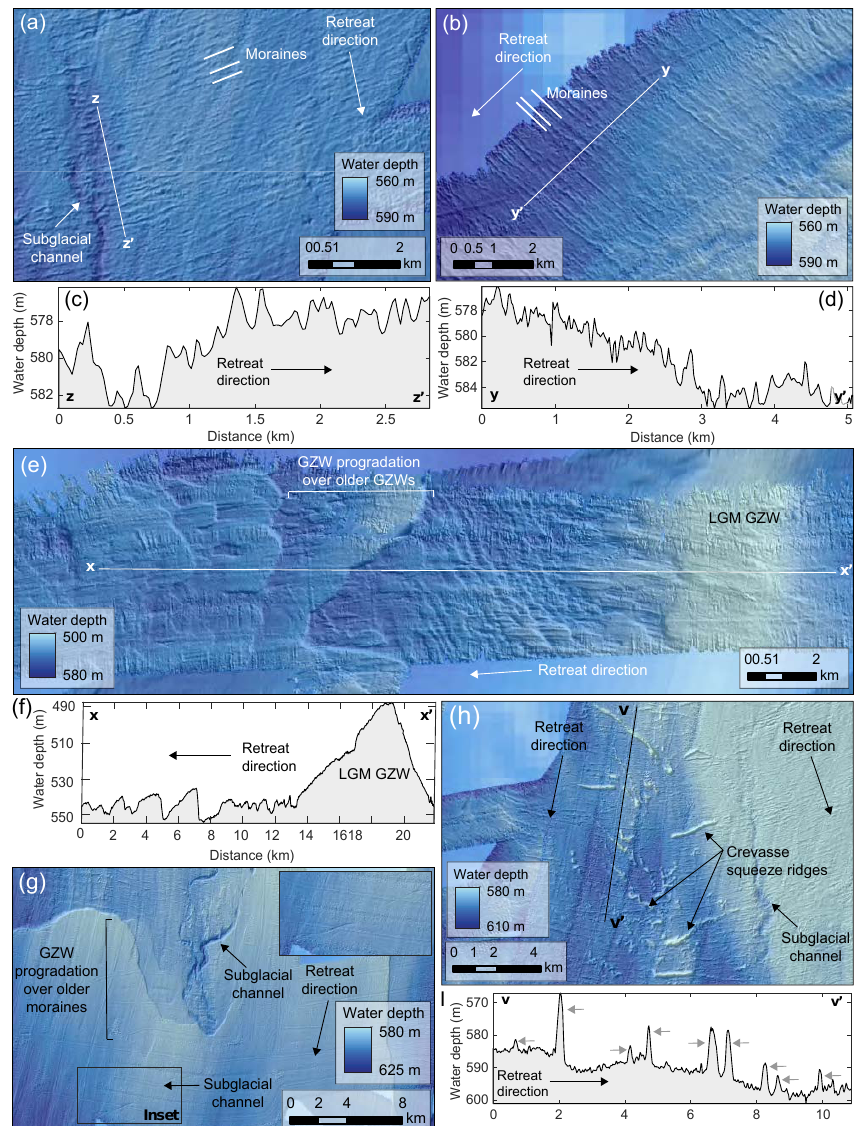
Figure 3. Recessional moraines (a) on relatively flat seafloor in the JOIDES Trough overprint a previously active subglacial channel and (b) on a reverse bed in Pennell Trough. (c, d) Corresponding profiles across the fields of recessional moraines shown in (a) and (b) . (e, f) A suite of various sizes of grounding zone wedges in Pennell Trough, most of which are overprinted by glacial lineations. The largest grounding zone wedge formed at the Last Glacial Maximum, marking the seaward-most extent of grounded ice, whereas the smaller grounding zone wedges formed during retreat across a normal sloping bed. (g) A grounding zone wedge in JOIDES Trough with a large embayment, from which an earlier subglacial meltwater channel emanates and into which a small channel on the wedge topset leads. This grounding zone wedge is not lineated like the examples shown in (e) . (h, i) Crevasse-squeeze ridges (CSRs) with irregular form and variable amplitudes amid a field of recessional moraines. Examples of crevasse-squeeze ridges shown in (h) and labelled by grey arrows in (i) .